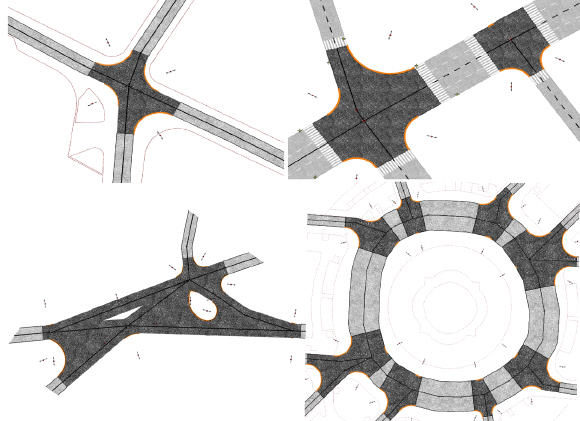
Figure 13: Example of results of increasingly complex intersec- tion.